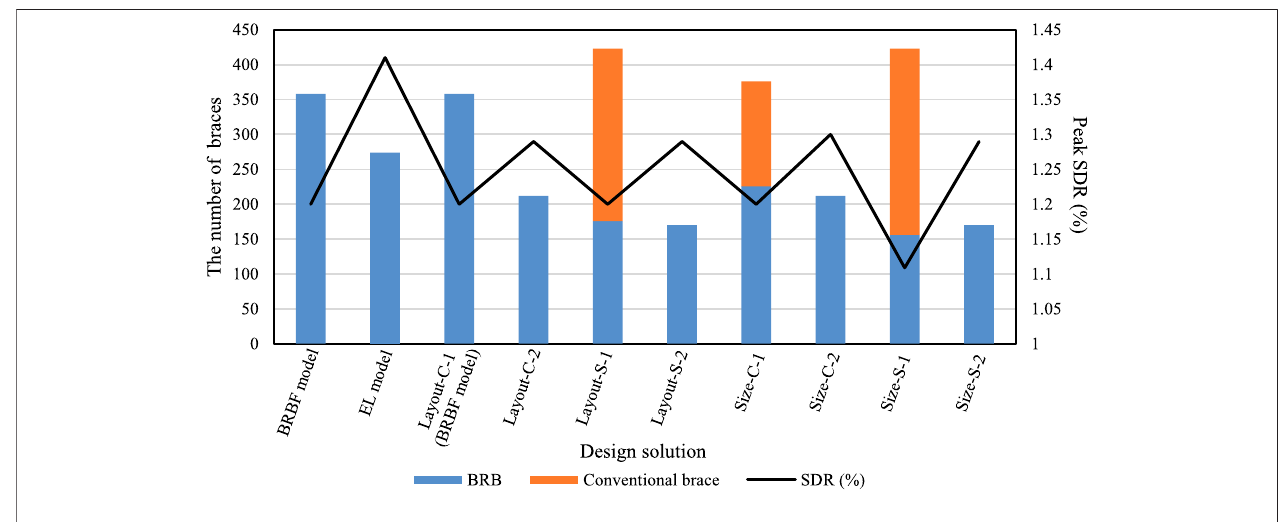
FIGURE 12 | Comparison of the optimal